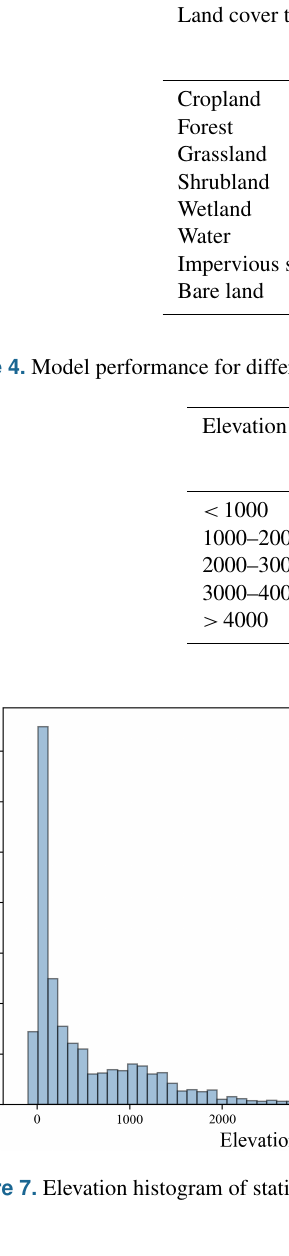
Table 3. Model performance for different land cover types.